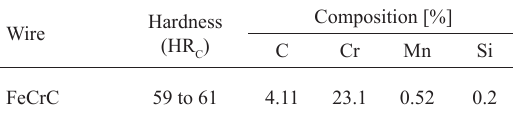
Table 1: Chemical composition and hardness of the tubular wire